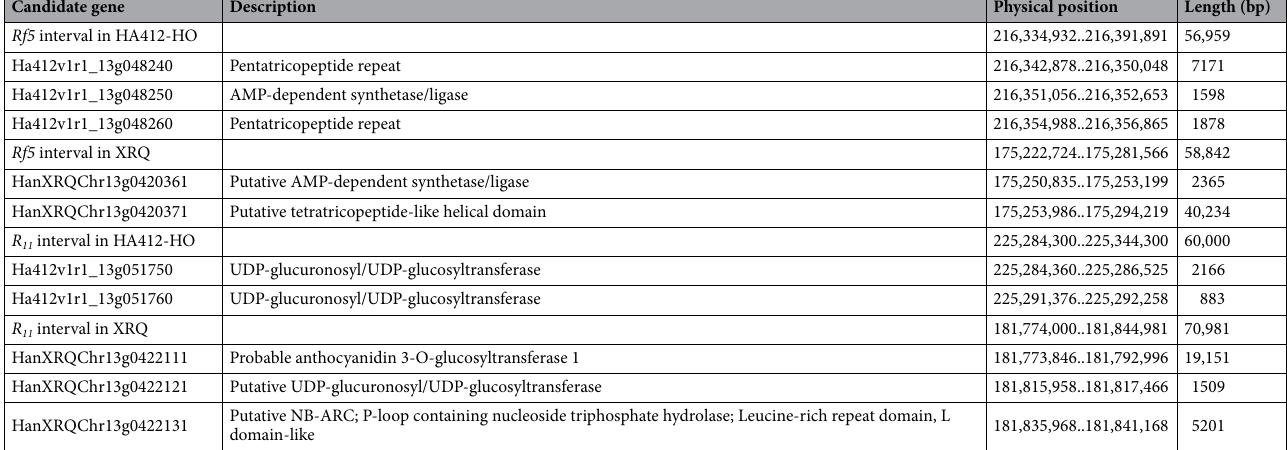
Table 3. The candidate genes for the male fertility restoration gene Rf5 and the rust resistance gene R 11 from the reference